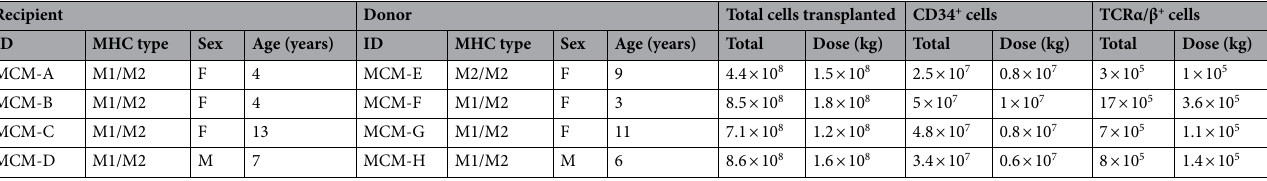
Table 1. MCM characteristics and doses of transplanted cells.